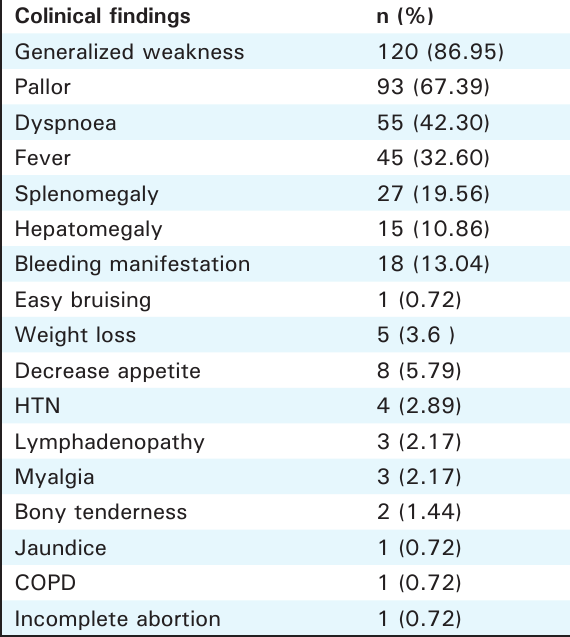
Table 2. Presenting complaints and clinical